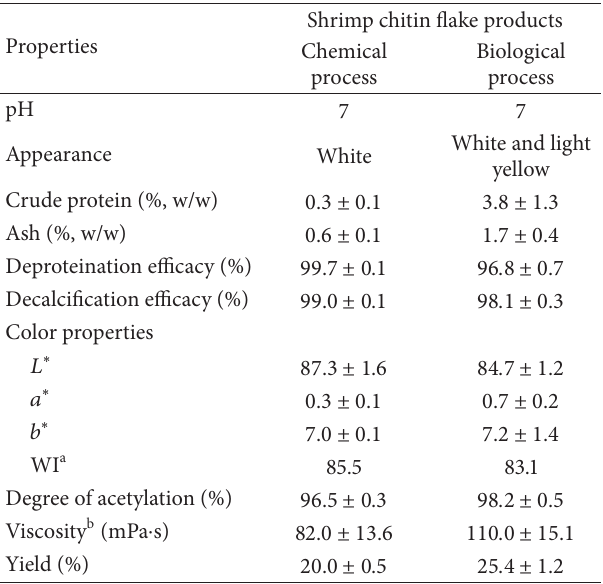
Table4:Propertiesofchitinflakesobtainedfromchemicalandtwo- Table 5: Properties of chitosan flakes obtained from deacetylation of chitin extracted by chemical and two-step biological